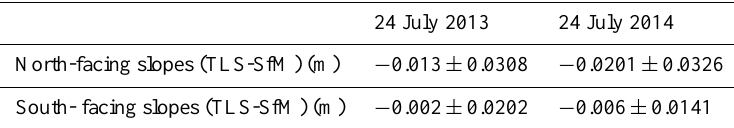
Table 4. Mean differences and standard deviation of point clouds obtained with both methods calculated for the first and last